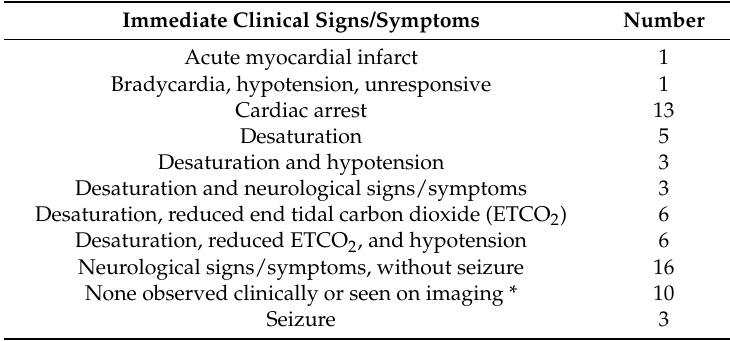
Table 5. Immediate clinical signs and symptoms associated with air embolism.